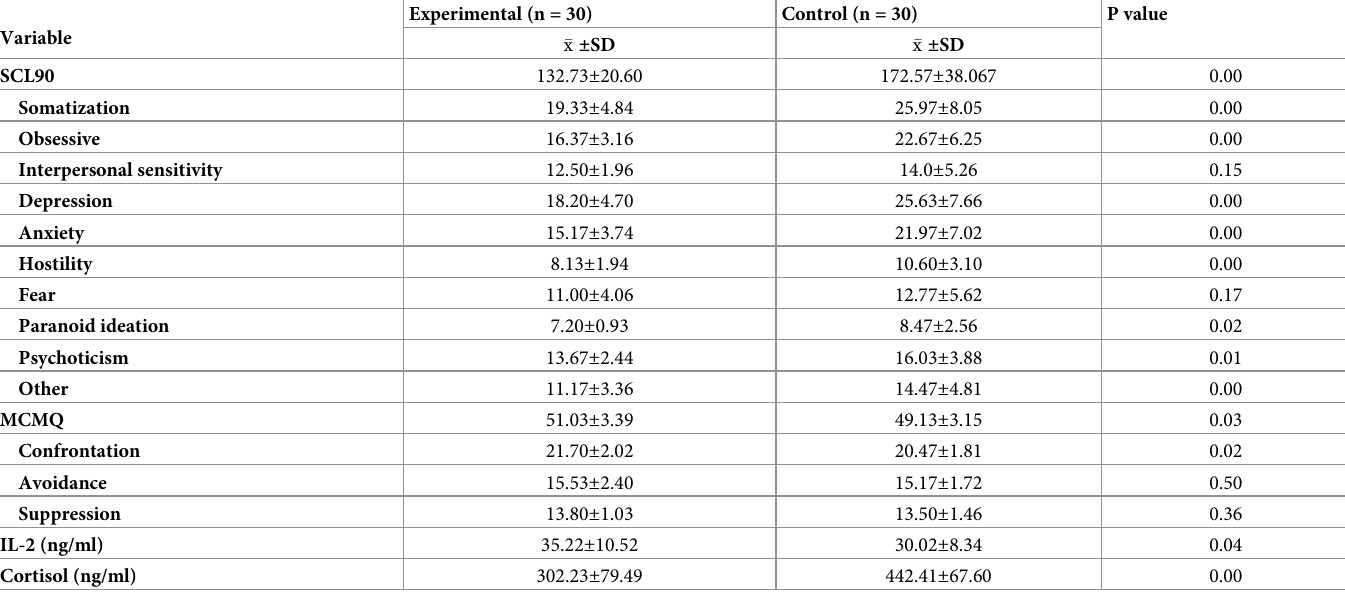
Table 4. Comparison of SCL-90, MCMQ, IL-2 and cortisol between groups after the intervention.